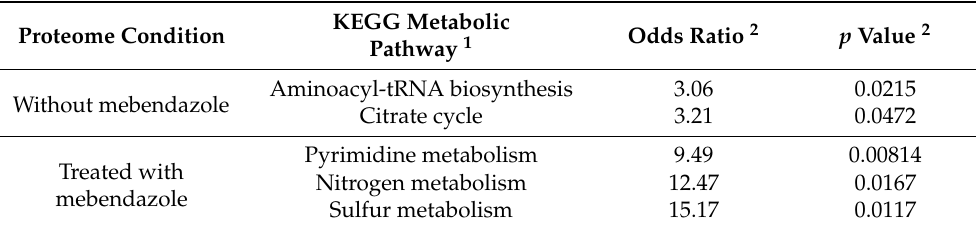
Table 3. Metabolic pathway enrichment analysis of proteomes derived from untreated and mebendazole-treated H. capsulatum G217B yeast-like cells.